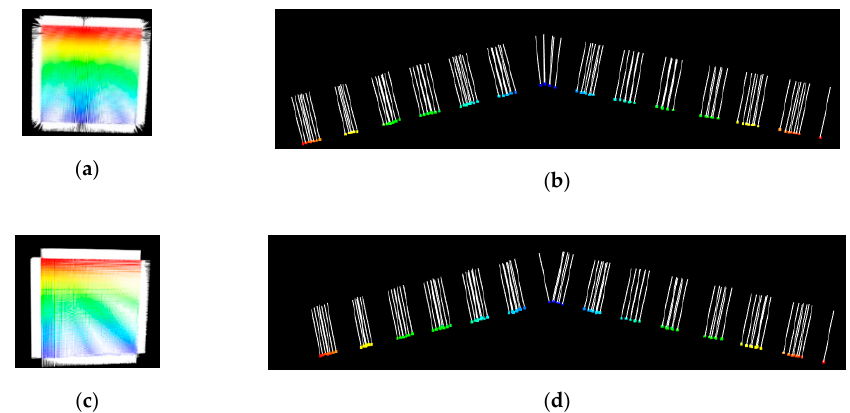
Figure 2. Normal vector. ( a ) PCA-based normal vector of a cube; ( b ) PCA-based normal vector of a building roof; ( c ) LRSC -based normal vector of a cube; ( d ) LRSC -based normal vector of a building roof